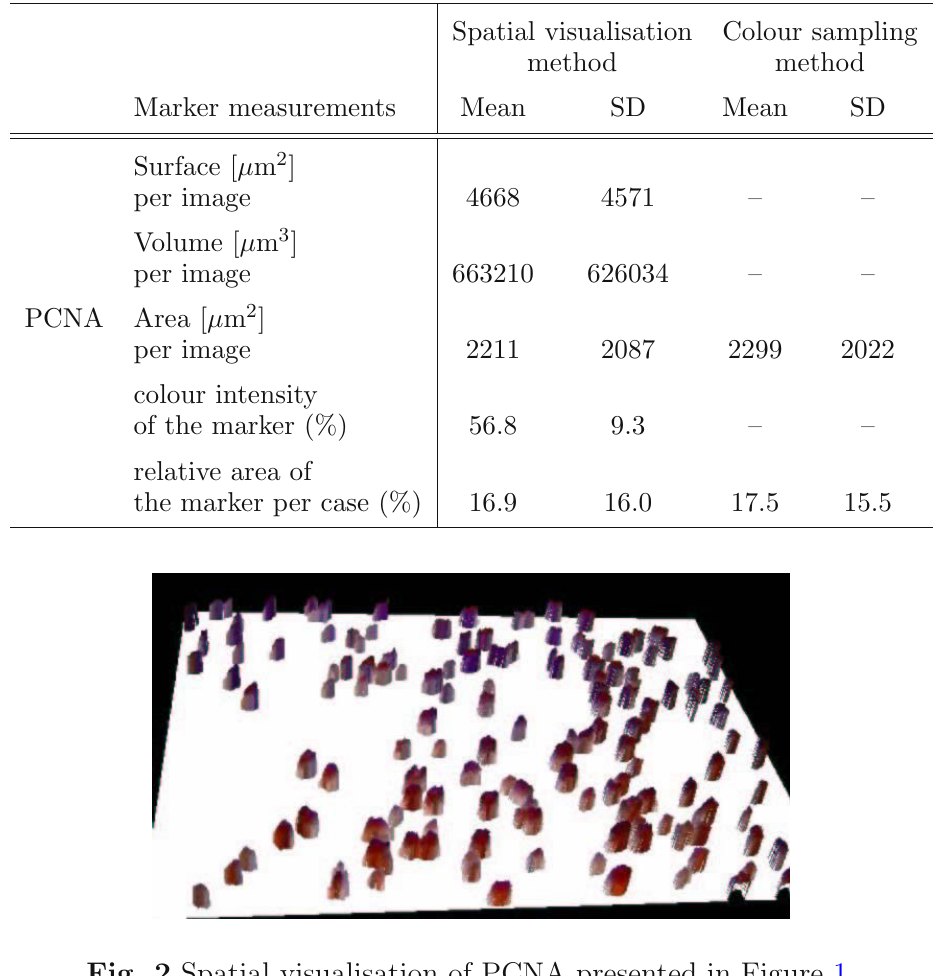
Table 1 Quantitative measurements of PCNA in twenty chronic parathyroiditis cases.